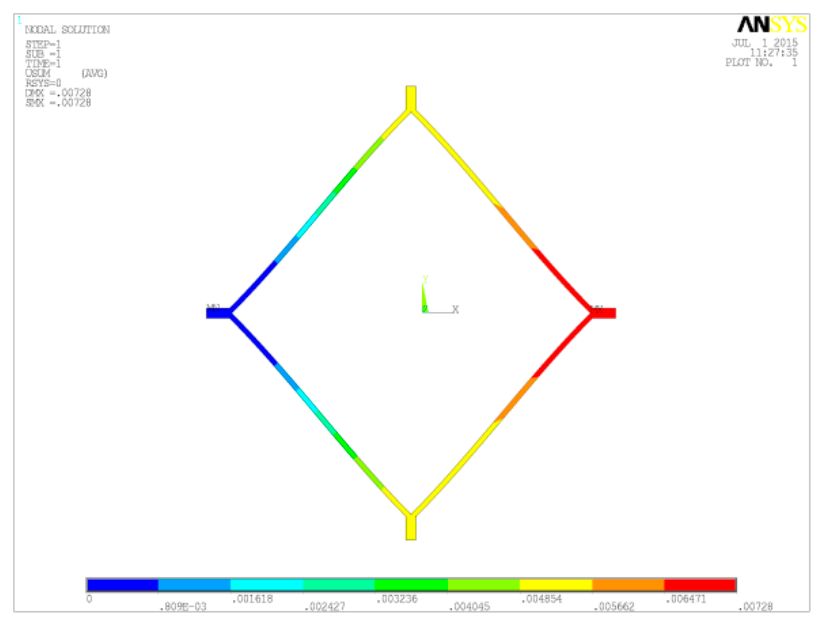
Figure 6. The stiffness of the direct diamond coupling beam in the anti-phase mode.